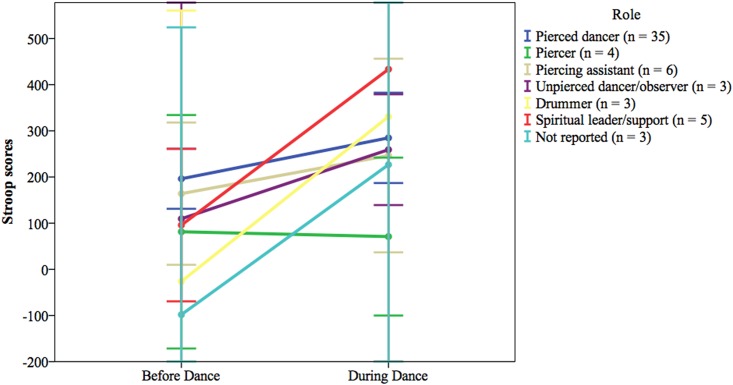
Stroop scores by all roles.The following participants completed both baseline and during-Dance Stroop task: 35 pierced dancers, 4 piercers, 6 piercing assistants, 3 non-pierced dancers/observers, 3 drummers, 5 spiritual leaders, 3 unknown/missing role. Error bars are 95% confidence intervals. The following upper error bars were truncated at 600: Before Dance/Unpierced dancer/observer, During Dance/Drummer, During Dance/Spiritual leader/support, and During Dance/Not reported. The following lower error bars were truncated at -200: Before Dance/Unpierced dancer/observer, Before Dance/Drummer, Before Dance/Not reported, During Dance/Drummer, During Dance/Spiritual leader/support, and During Dance/Not reported.